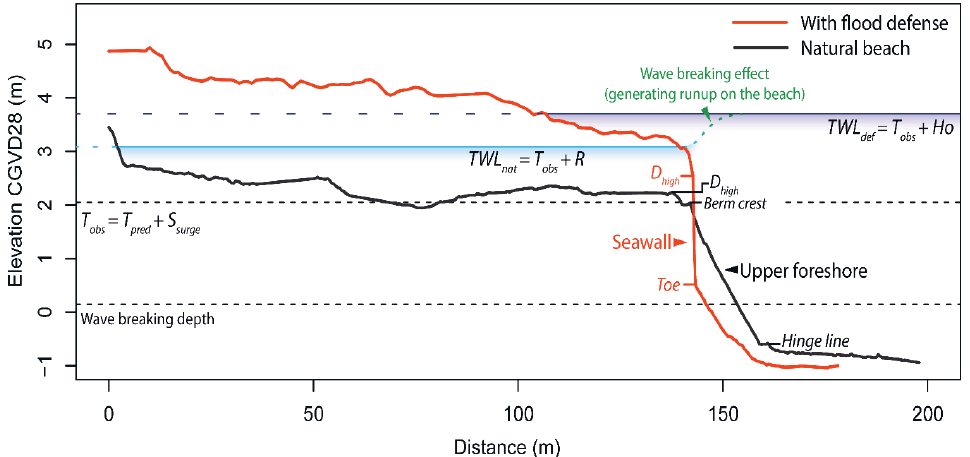
Figure 5. Natural beach slopes definitions used in the empirical runup formula. The slope tanβ 1.5H0 is located between the point of maximum runup elevation on the beach ( R max ) and T obs − 1.5H 0 . The upper foreshore slope ( tanβ ufs ) is located between the point of maximum runup elevation and the hinge line. See the profile location in Figure 10, on the beach only (black line).